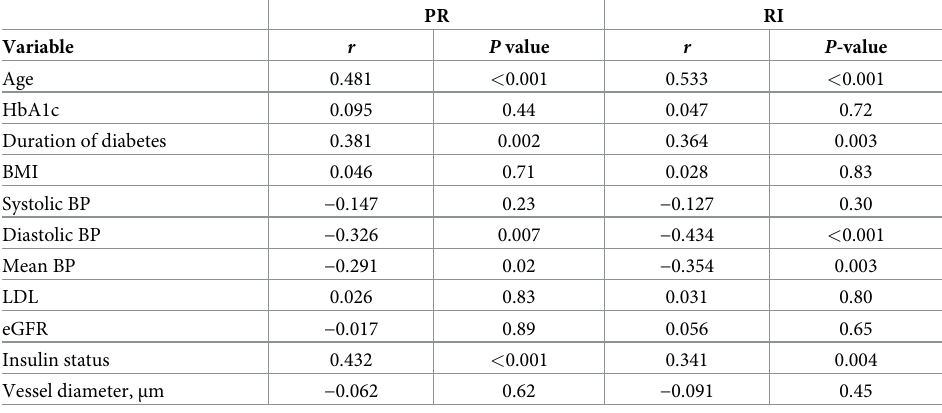
Table 5. Characteristics of 68 patients with type 2 diabetes with early-stage DR and correlations of PR and RI with systemic and ocular